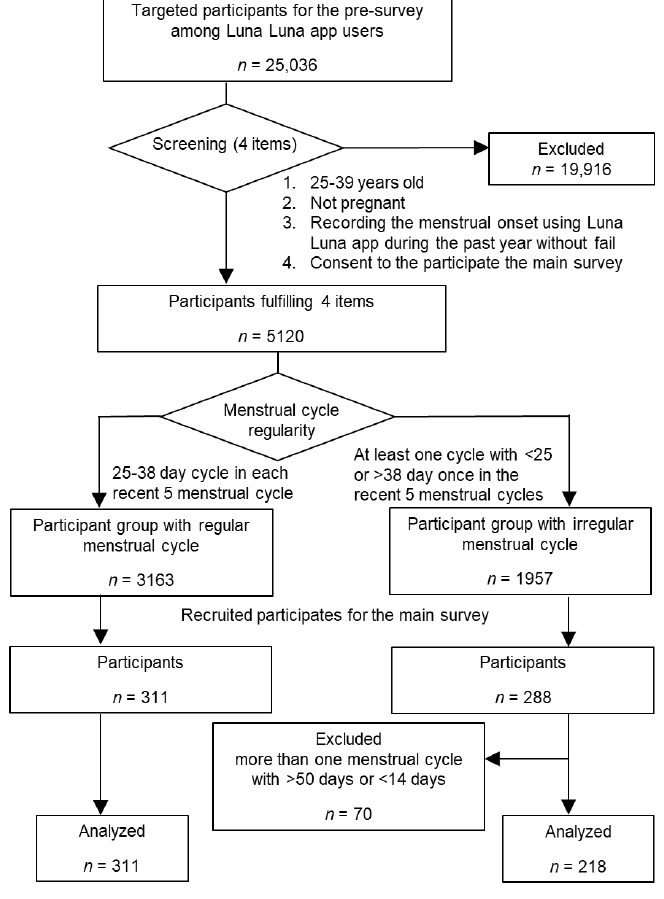
Figure 1. Study design flowchart.